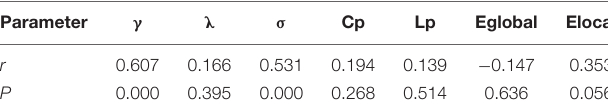
TABLE 3 | Correlation analysis between AUC of topological parameters of the functional networks of the brain and scores of the cognitive function of patients with